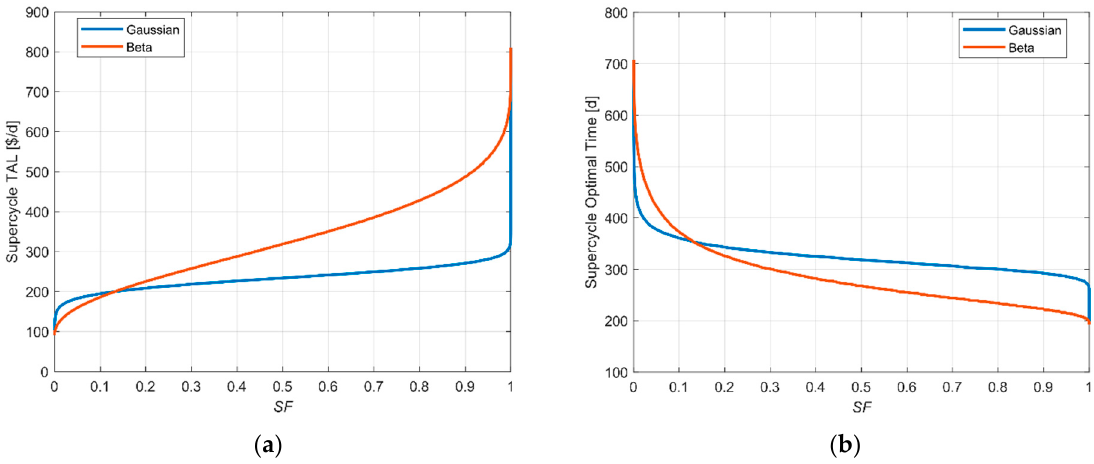
Figure 10. Flexibility analysis results—supercycle: ( a ) Optimal supercycle TAL vs. SF ; ( b ) Optimal supercycle time vs. SF .